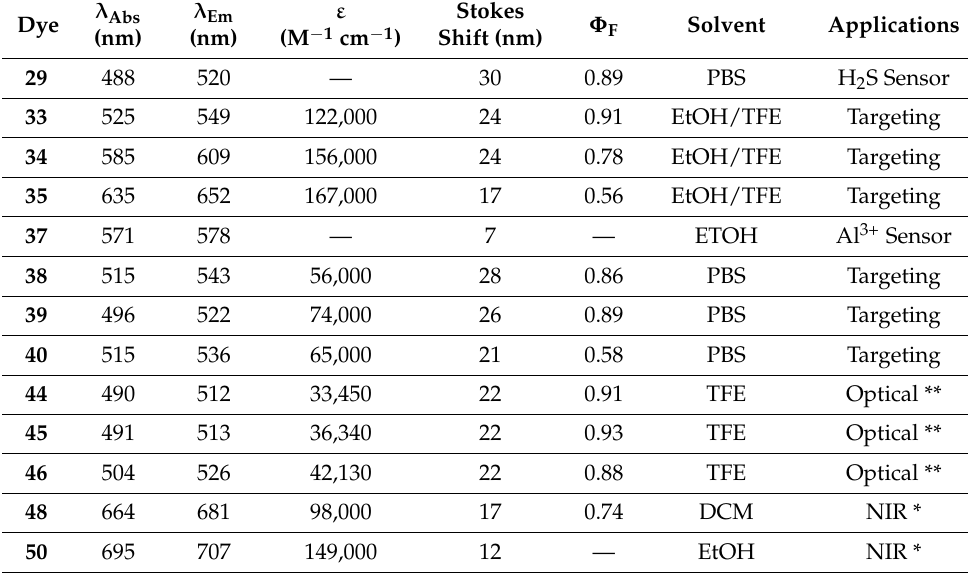
Table 2. Optical properties of selected fluorinated rhodamine